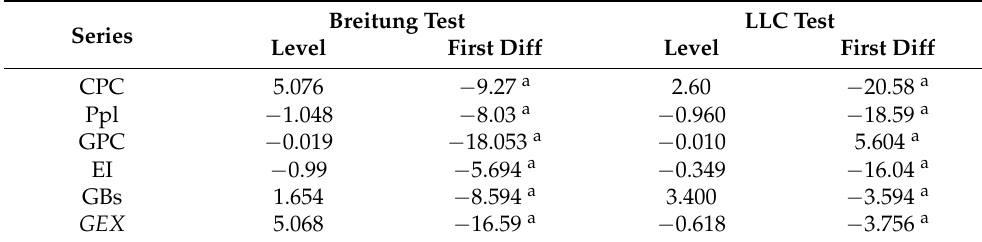
Table 4. The results of Breitung test and Levin-LinChu tests.